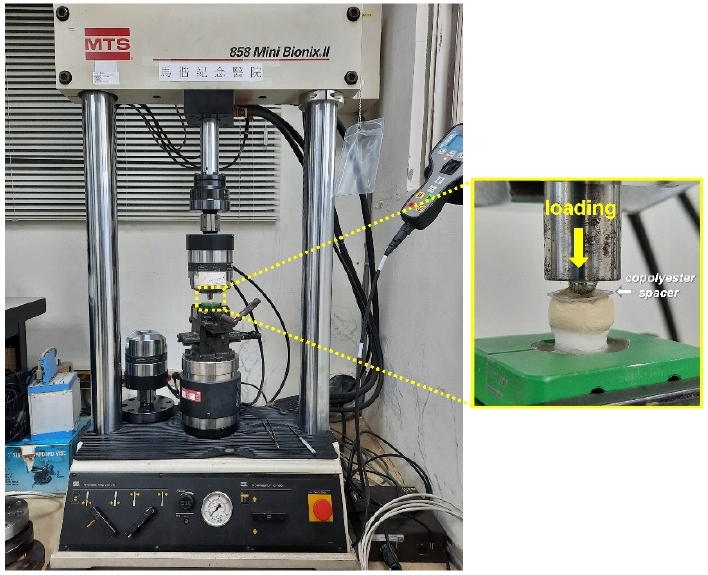
Figure 3. Compression test machine ( left ) and higher magnification of test PEEK crown during loading ( right ).